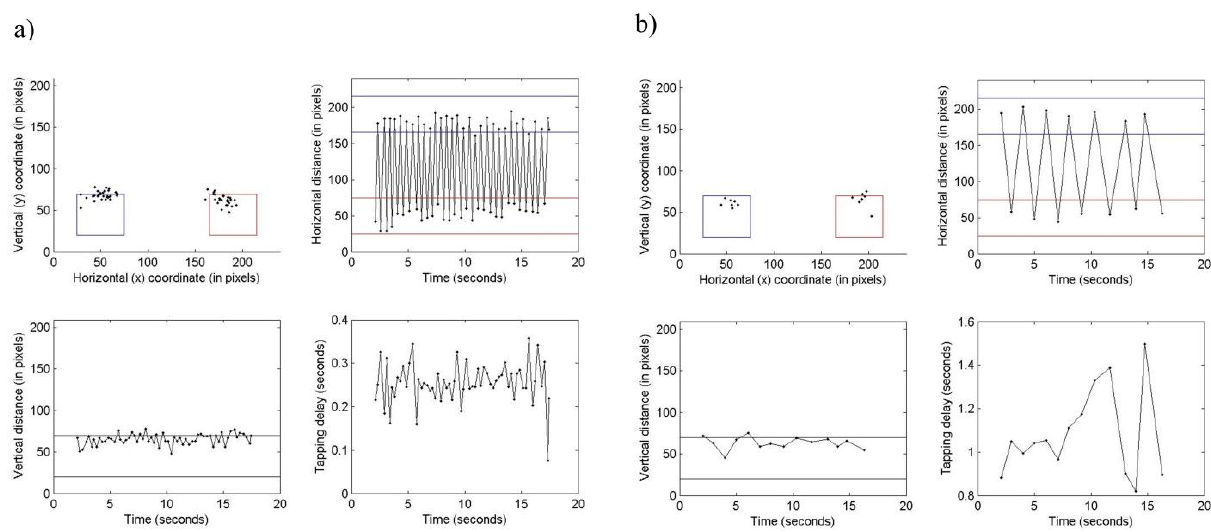
Figure 2. Two illustrative examples of visualized ATP in the web-based system. ( a ) A test occasion with V-SPEED, V-ARRHTYHMIA, V-FATIGUE and V-GTS rated 0 (normal) and V-ACCURACY 1 (mild). ( b ) A test occasion with V-SPEED rated 4 (extremely severe), V-ACCURACY 1 (mild), V-FATIGUE 3 (severe), V-ARRHYTHMIA 0 (normal) and V-GTS 4 (extremely severe). The left field is represented with blue color. The right field is represented with red